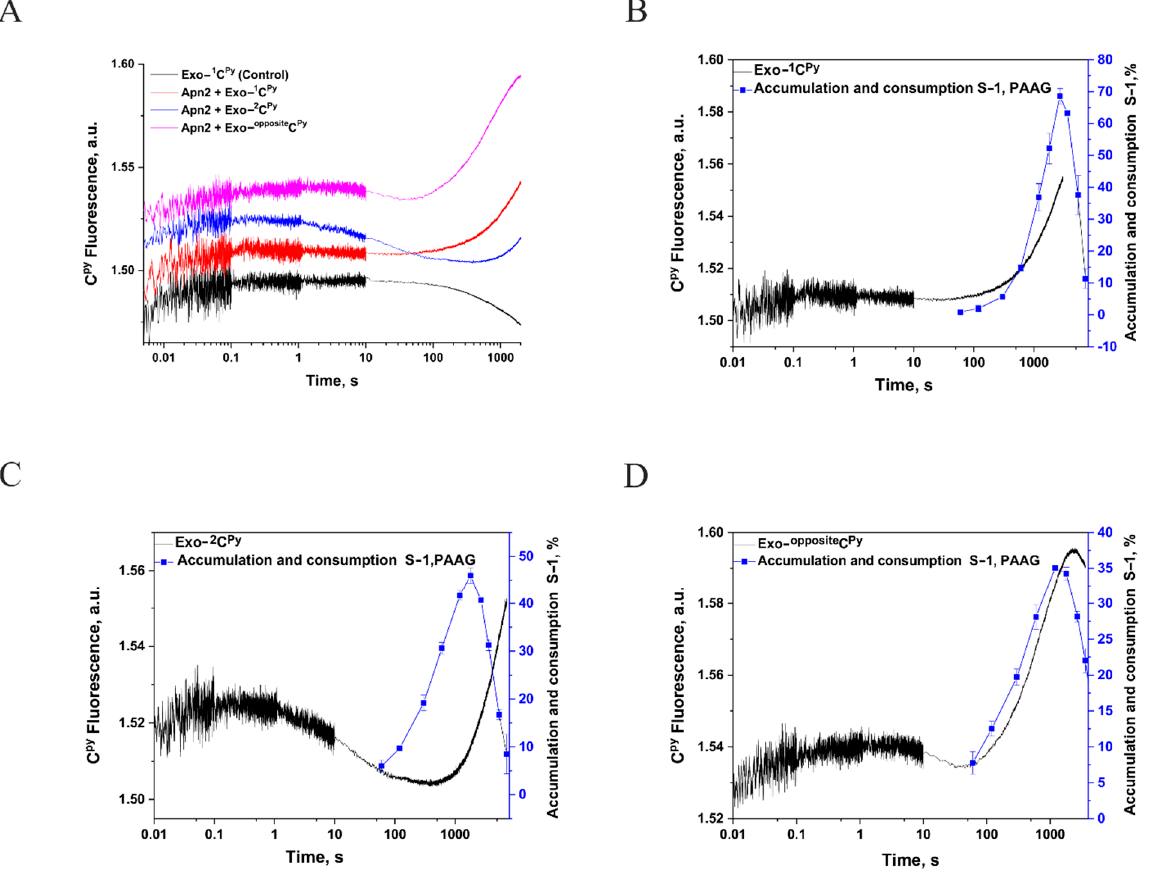
Figure 8. ( A ) Time dependence of the fluorescence intensity of C py during the interaction of Apn2 with DNA duplexes containing this fluorescent label at one of three positions. A comparison of kinetic curves recorded using changes in C py fluorescence intensity during the interaction of Apn2 with DNA duplexes Exo– 1 C py ( B ), Exo– 2 C py ( C ), or Exo– opposite C py ( D ) and those recorded using the accumulation of reaction products in a PAAG ([S] = 1 μ M, [E] = 2 μ M, Т = 37 °C).